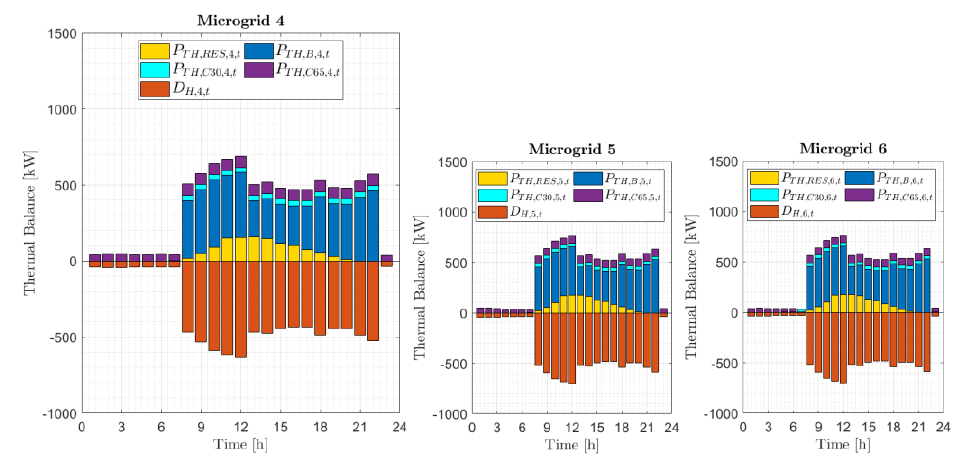
Figure 14. Thermal balance in the LUs (microgrids).